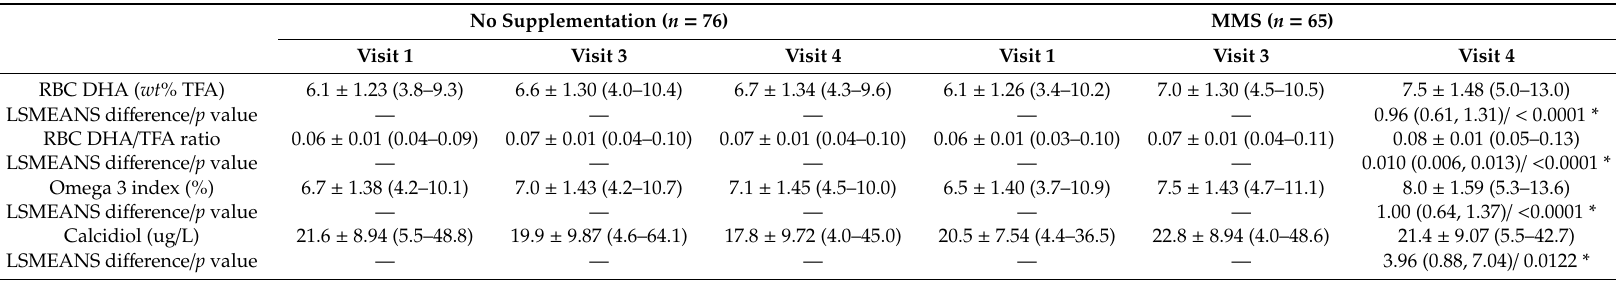
Table 2. Primary and secondary outcomes at each visit (LOCF approach; values presented as mean ± standard deviation (range)) and di ff erences between groups from Visit 1 to Visit 4 (presented as LSMEANS (95% confidence interval), ANCOVA model) (per protocol